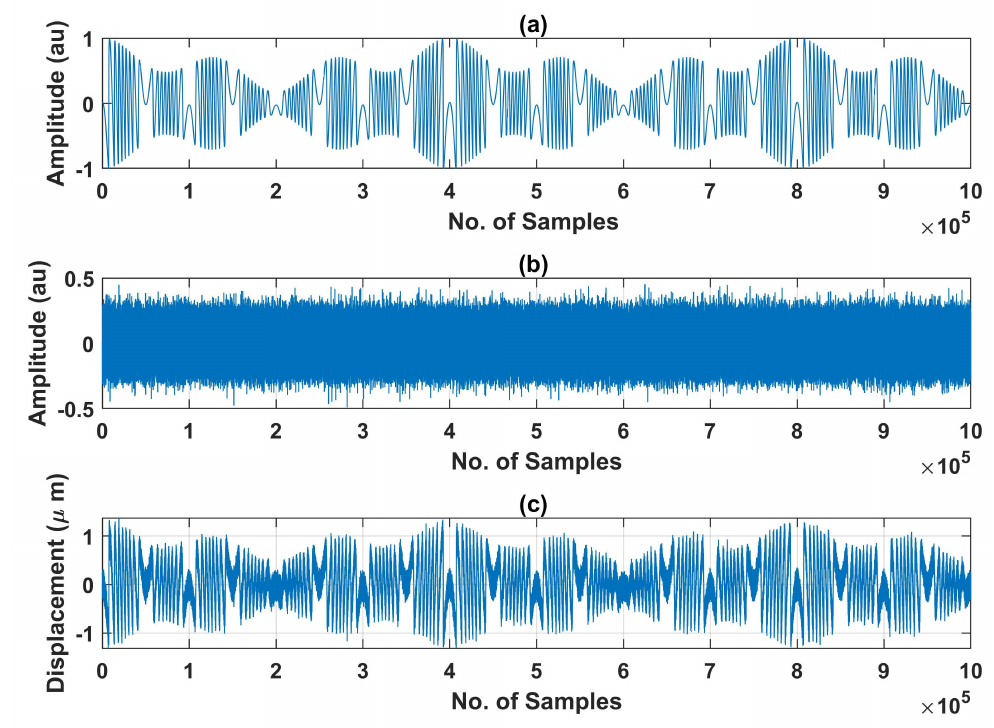
Figure 5. Addition of noise to noiseless variable C -based SMI signal: ( a ) noiseless SMI signal ( b ) noise signal, and ( c ) noisy SMI signal obtained by addition of the noiseless SMI signal and the noise signal. After the noise is added, the corresponding SMI signal is processed to place bounding boxes on its fringes in an automated manner by using the transition value (1 and − 1) as class identity